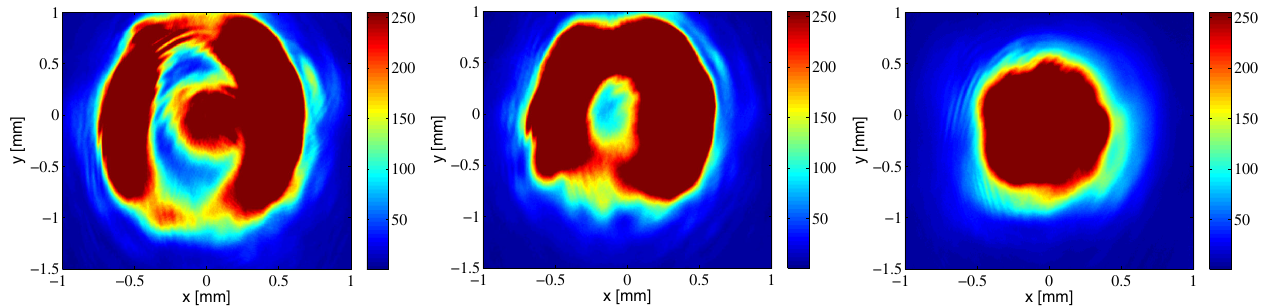
FIG. 8. Spatial profiles of the 400 nm coherent photon beam observed on the CCD camera downstream of the